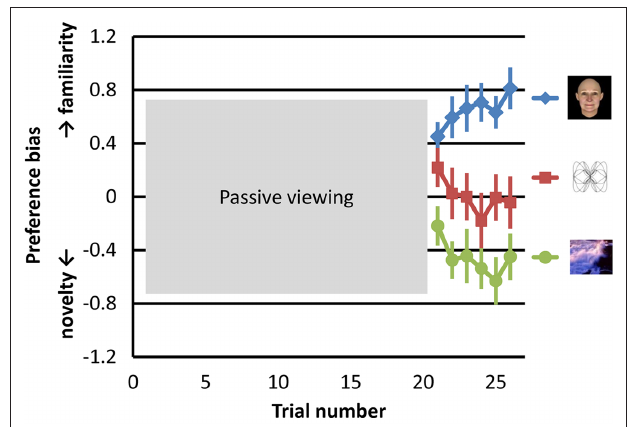
Figure 3 | Timelines of preference bias in experiment 1. Data points are trial-by-trial means of ratings rectified toward the repeated image. Error bars represent one standard error of the